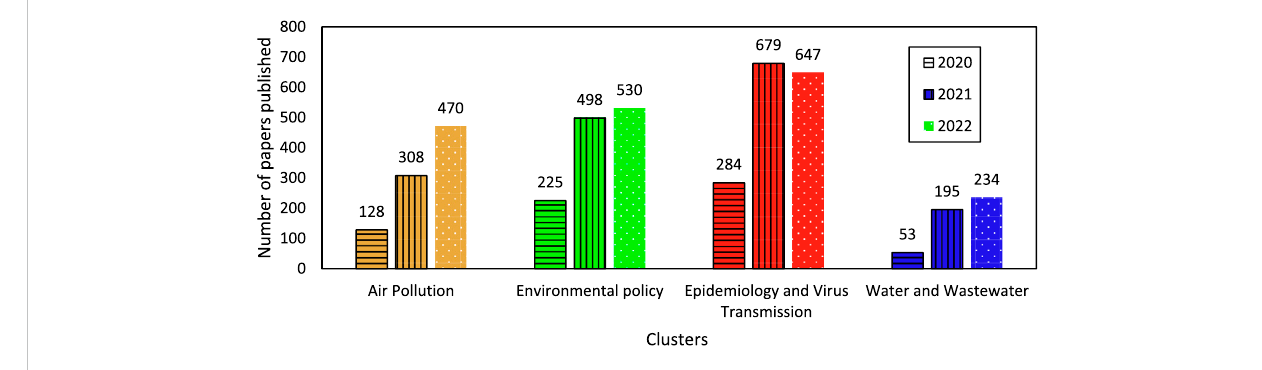
FIGURE 3 The published papers in 2020, 2021, and 2022 are presented based on the clusters (Air pollution, Environmental policy, Epidemiology and Virus Transmission, Water and Wastewater).